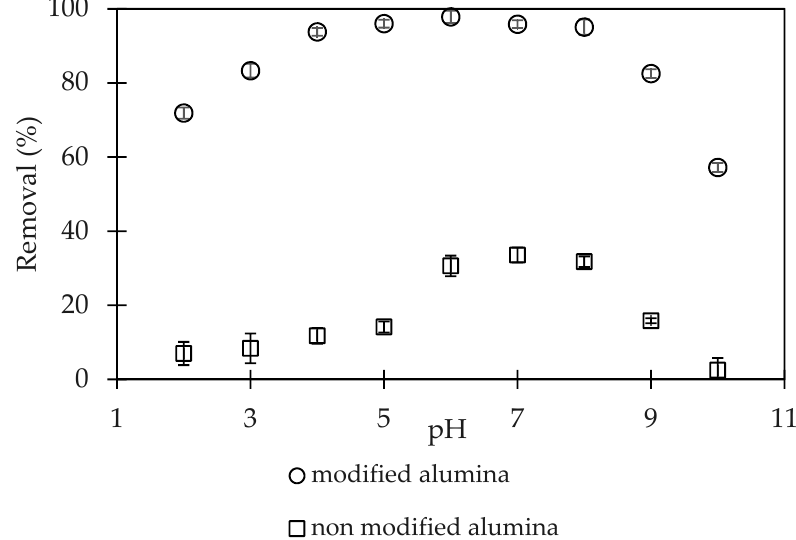
Figure 3. Effect of pH on ciprofloxacin (CFX) removal using α -Al 2 O 3 (non-modified alumina) and PMA (modified Al 2 O 3 ) from pH 2 to 10. (Ci (CFX) = 10 mg/L, contact time 90 min, adsorbent dosage 5 mg/mL, 1-mM NaCl). Error bars show standard deviation of three replicates.